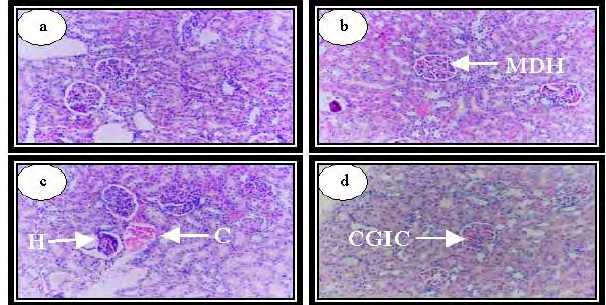
Figure 10 : Histopathology of lung from female rats treated with saline (a) showing normal pulmonary tissue; AcAaIT (b) showing mild thickening (T) of some interaveolar septa; AcMNPV (c) showing vaculated bronchialar epithelium (VBE) and peribronchial lymphoid hyperplasia (PLH); and SlNPV (d) showing perivascular lymphoid aggregates (PLA) (H&E x300).